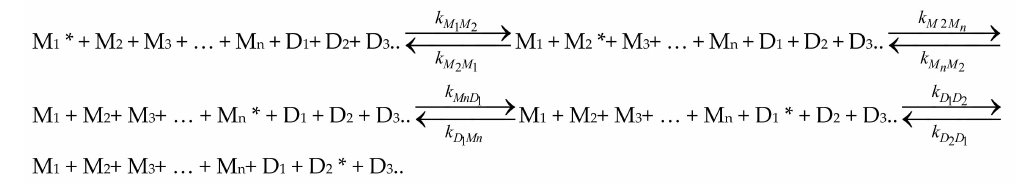
Scheme 1. Illustration of the energy migration end energy transfer processes in the monomer–dimer system. M * and D * denote the excited M and D molecules.